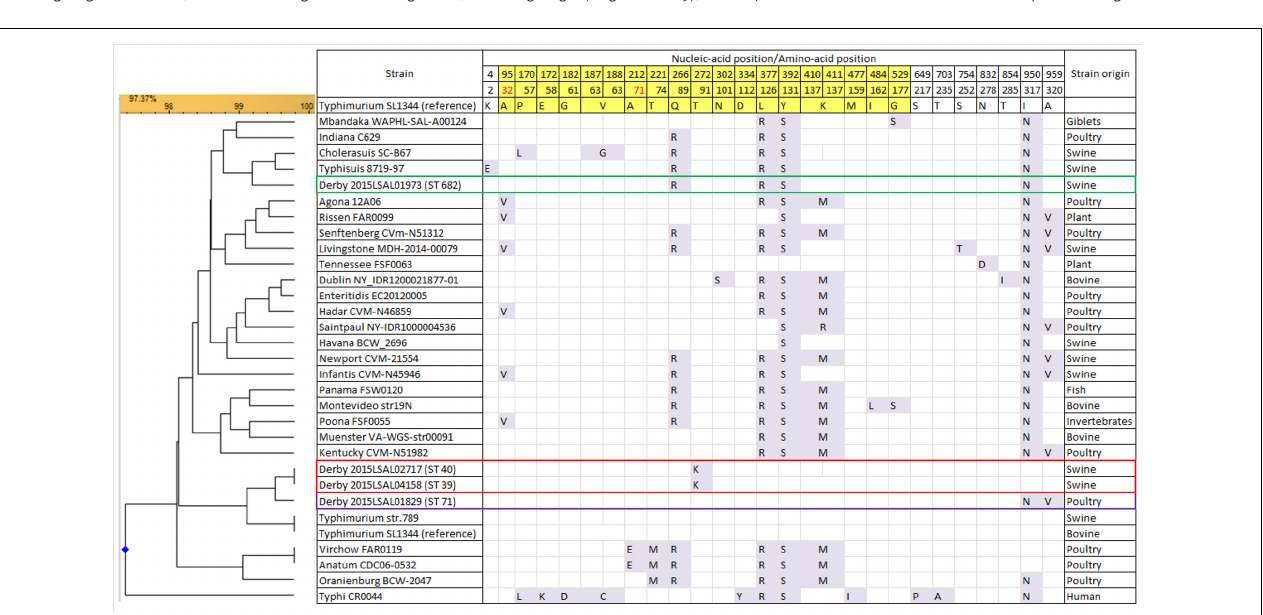
FIGURE 5 | Variant residue positions in the FimH protein sequence for 25 serotypes and some S . Derby strains of this study. The results show a 100% identity of the fimH sequences inside each ST lineage. Only three strains of each group are represented in the comparison, as examples. The residues belonging to the lectin domain (23–196, yellow background) and the pilin domain (199–335, white background) are framed, for a total of 27 missense SNPs (23 already described and 4 new ones) for a total of 17 mutations of the lectin domain and 9 of the pilin domain. The residues in red are known to be part of the mannose binding